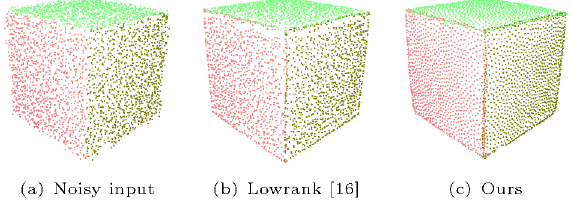
Fig. 21 Filtered points of ours and Lowrank [16].